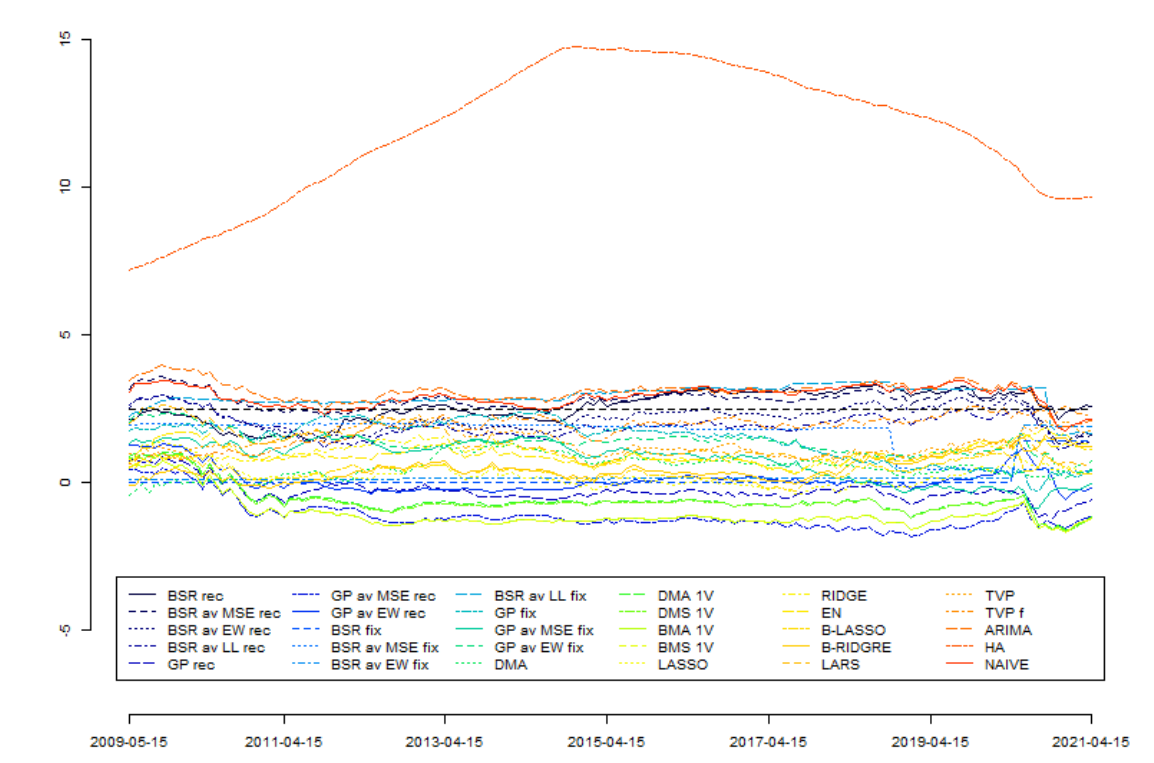
Figure 1. Results of the Giacomini–Rossi fluctuation test for various parameter µ and loss functions.